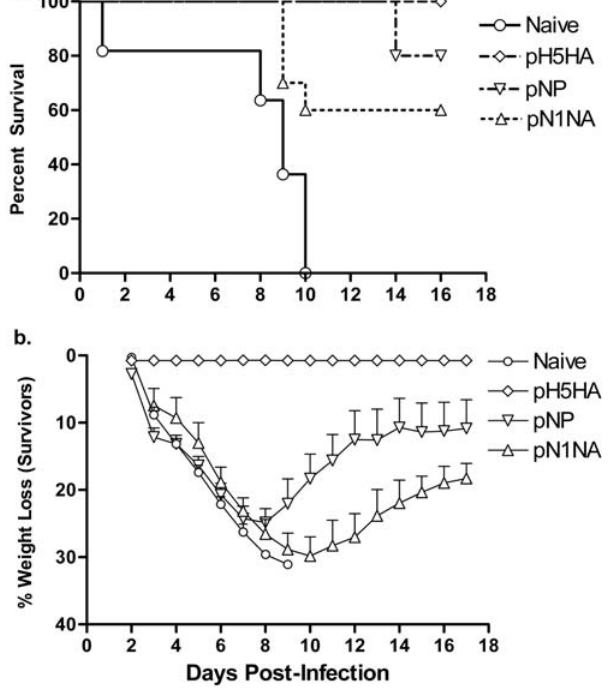
Figure 2. Results following an H5N1 challenge of immunized mice. Mice were challenged with 100LD 50 of an H5N1 virus (A/Hanoi/ 05/2005). (a) Kaplan-Meier curve showing the percent survival in each group. (b) Average weight loss among the surviving members of each group (and the weight loss seen in naı¨ve mice before death). Error bars represent 1 standard deviation from the mean, and are shown only in the positive direction for clarity.